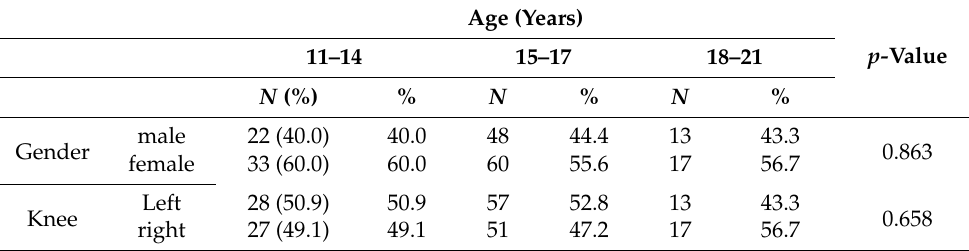
Table 1. Knee injury prevalence by age